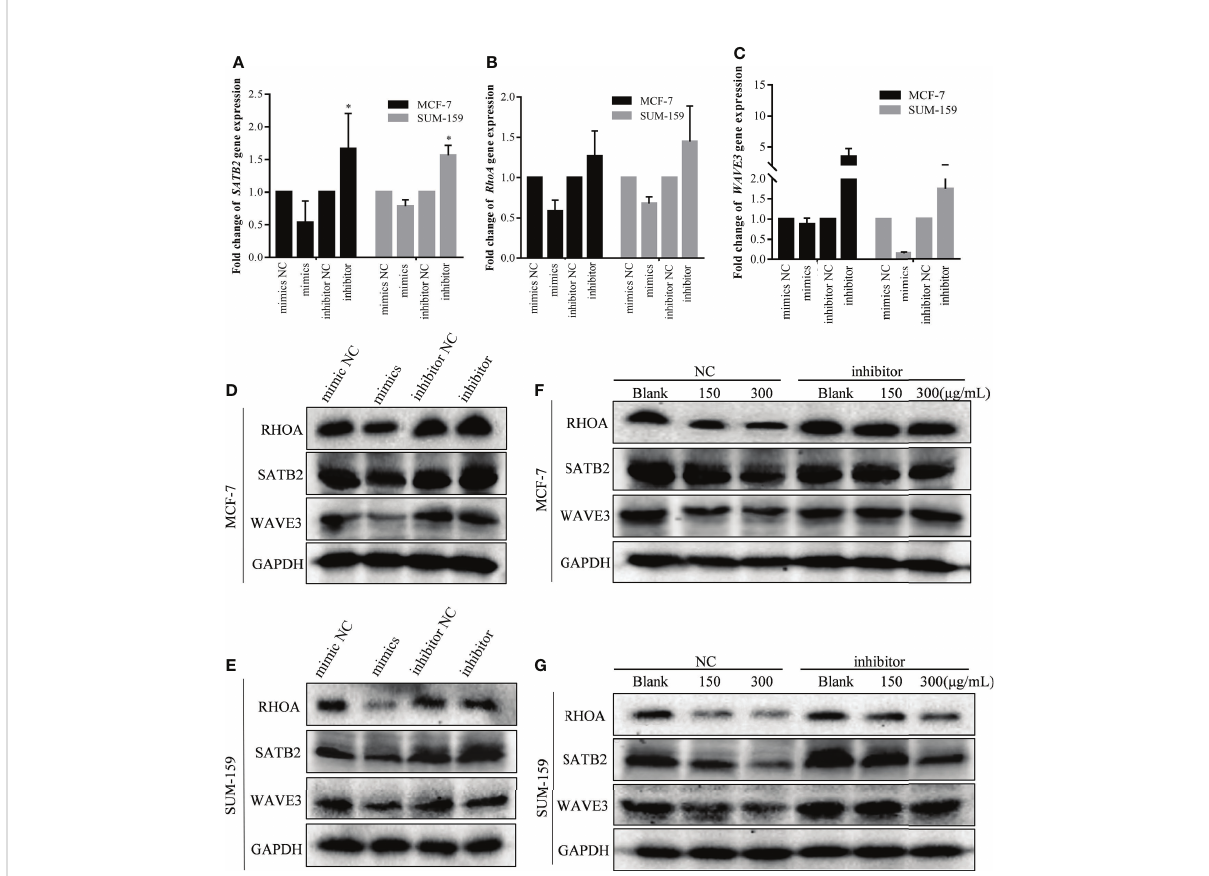
FIGURE 3 The effect of GBK treatment on miR-31 target gene expression after transfected with miR-31 mimics and inhibitor in MCF-7 and SUM-159 cells. (A – C) The MCF-7 and SUM-159 cells were transfected with miR-31 mimics or inhibitor, and different concentrations of GBK were added. After 24 hours, expression of SATB2 , RHOA and WAVE3 was analyzed by RT-qPCR. Data are presented as mean ± s.e.m. of three independent experiments. Student ’ s t test, * p<0.05. (D, E) Protein expression levels of miR-31 target genes after transfection with miR-31 mimics or inhibitor in MCF-7 and SUM-159 cells. Cell lysates were analyzed by western blot. (F, G) Protein expression levels of miR-31 target genes related to cell migration and invasion. Cells were transfected with miR-31 inhibitor for 24 h and then treated with GBK gradient for another 24 h in MCF-7 and SUM-159 cells. Cell lysates were analyzed by western blot. GAPDH was used as an internal